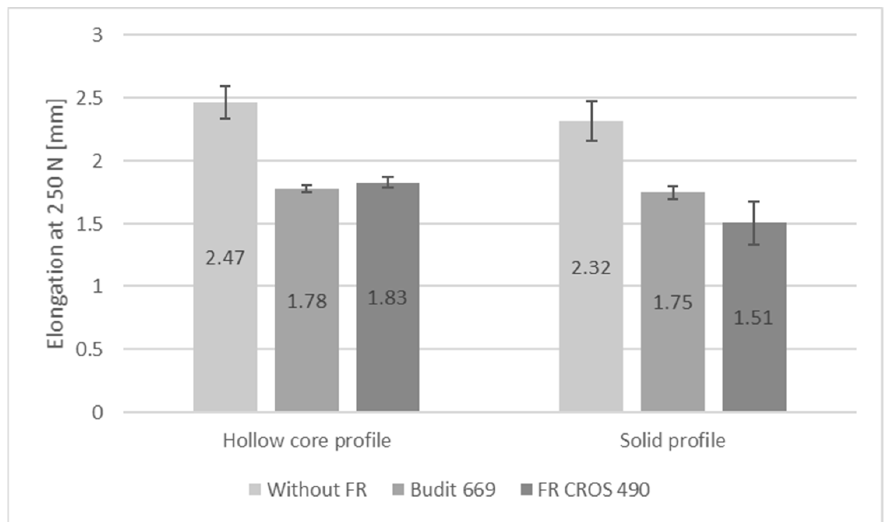
Figure 10. Flexural modulus of co-extruded profiles with and without fire-retardants. No require- ment provided in DIN EN 15534-5. Test performed according to EN 310 with support span of 500 mm and test specimen length of 600 mm.